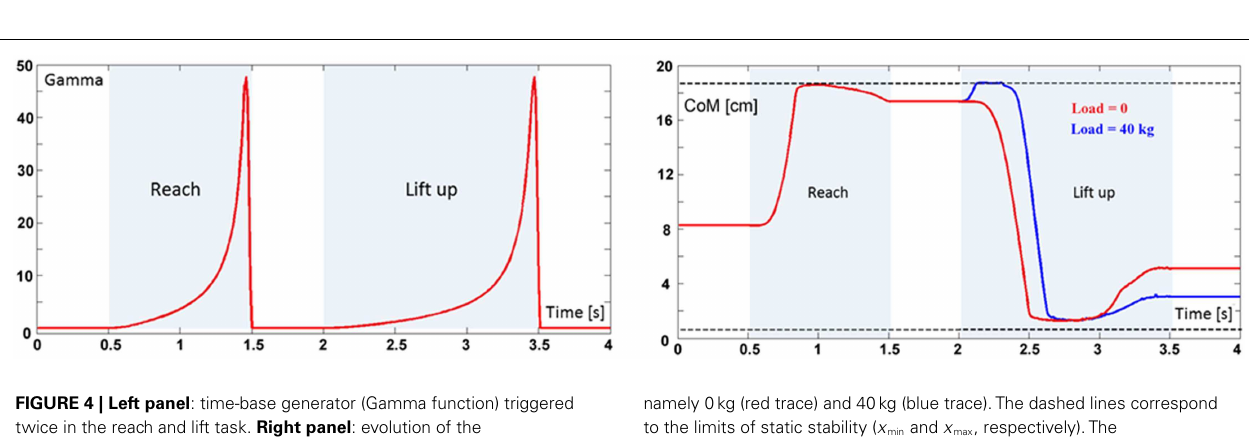
namely 0kg (red trace) and 40kg (blue trace).The dashed lines correspond to the limits of static stability ( x min and x max , respectively).The medio-lateral component can be neglected because this simulation is limited to in the sagittal